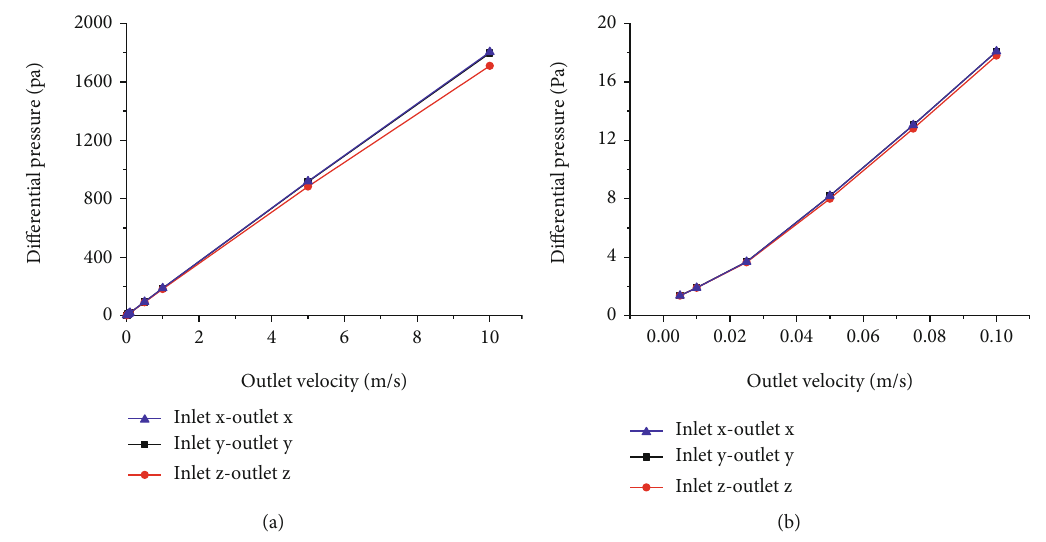
Figure 8: Curve of di ff erential pressure in di ff erent outlet velocity.